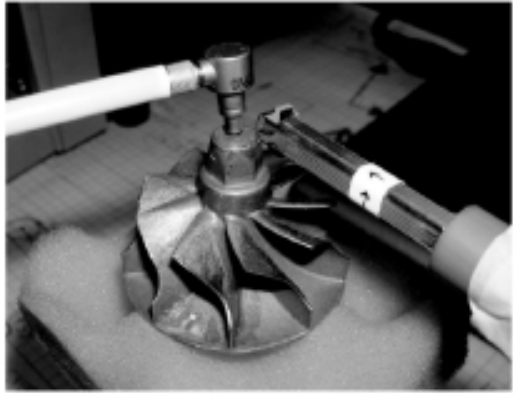
Fig. 9. The Microflown sensors and the micro